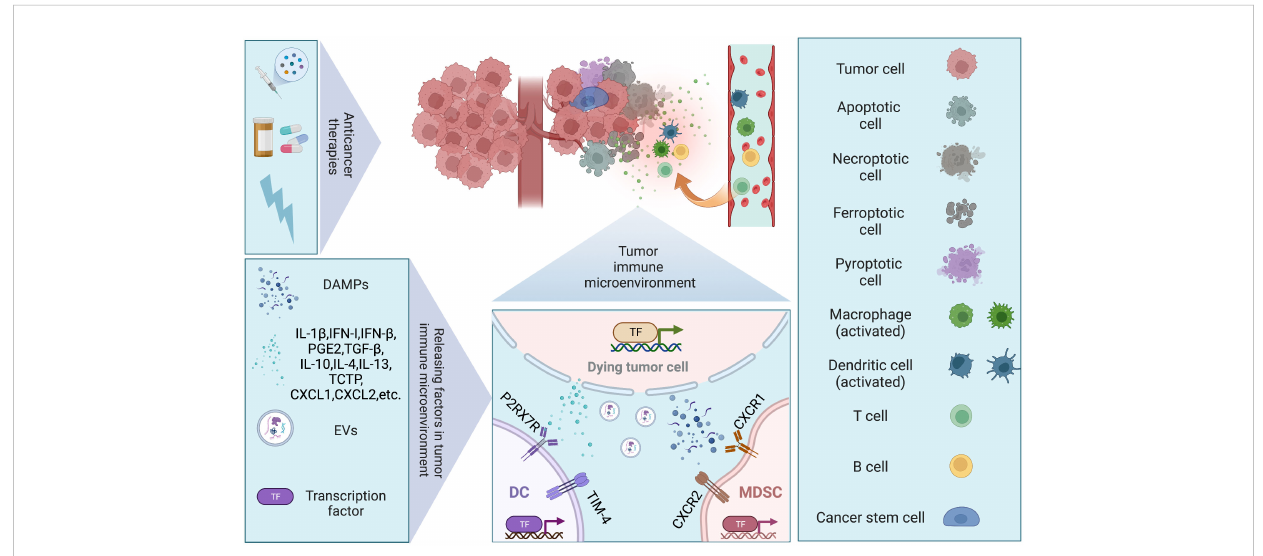
FIGURE 2 Dying tumor cells and tumor immune microenvironment. Conventional therapies (chemotherapy, targeted therapy, and radiotherapy) remain the mainstay of management in solid tumor, inducing different modalities of cell death. Regulated cell death (RCD), such as apoptosis, necroptosis, pyroptosis, and ferroptosis, have been discovered to trigger immune responses under the right circumstances, which are also known as immunogenic cell death (ICD). Under stresses, dying tumor cells release several factors including damage-associated molecular patterns (DAMPs), chemokines, cytokines, and extracellular vesicles (EVs), to modulate immune system via facilitating cancer stem cell repopulation, governing in fl ammation, promoting angiogenesis, reprogramming